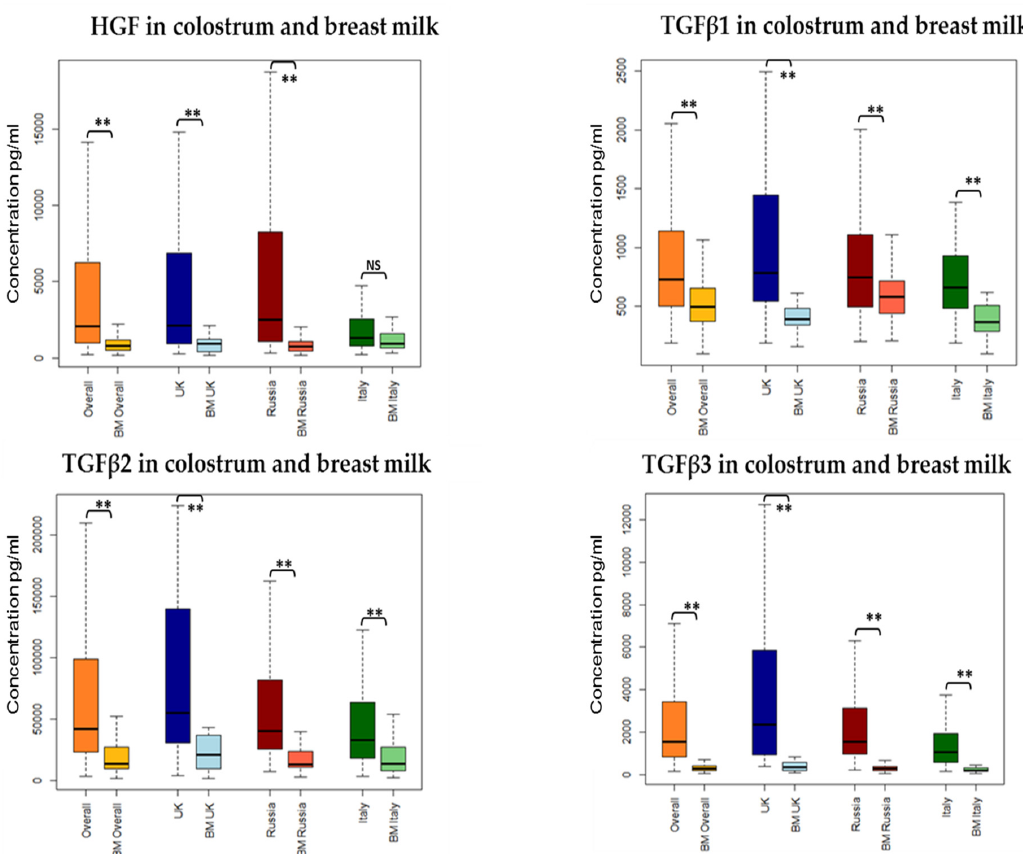
Figure 1. Unadjusted growth factors concentration (pg/mL) in colostrum and breast milk across all sites (overall) and at each site of collection (London, Moscow, and Verona). ** p value < 0.01.